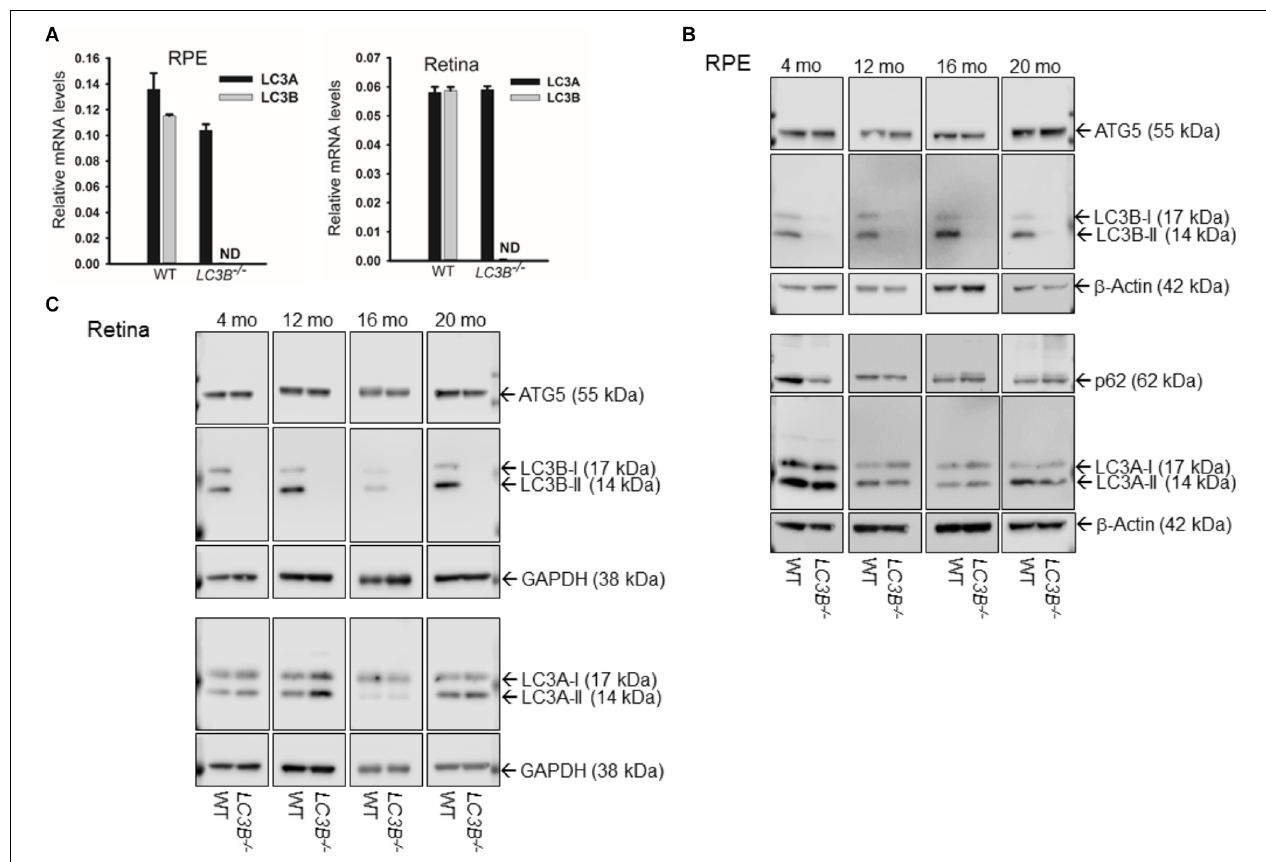
FIGURE 1 | (A) LC3A and (B) transcript levels by qRT-PCR in RPE (left) and retina (right) for WT and LC3B − / − mice as indicated. Results are mean ( ± SD) of three individual experiments (4 months). ND, not-detectable. (B) Representative immunoblots showing expression of ATG5, LC3B, P62/SQSTM1, and LC3A proteins in RPE from 4, 12, 16, and 20 months old mice. (C) Representative immunoblots showing expression of ATG5, LC3B, and LC3A proteins in retina from WT and LC3B − / − mice of different ages as indicated. The mice were sacrificed between 3 and 4 h after light